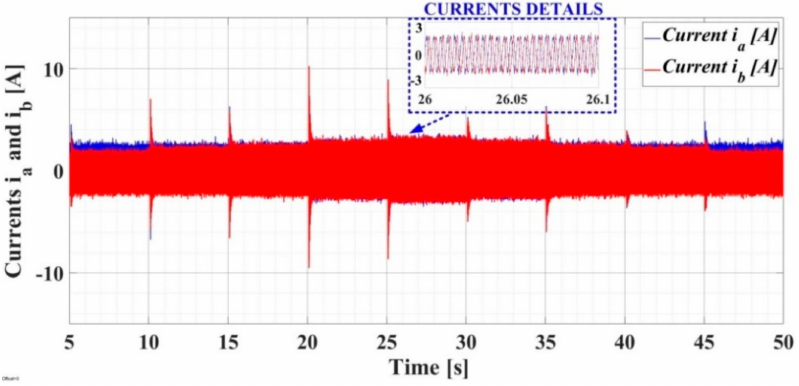
Figure 26. Real-time evolution of currents i a and i b for PMSM–CS–CI based on the LQR-type controller. It can be specified that the torque load of 1 Nm was provided by the TP 1410 drive system connected to the PMSM shaft. The TP 1410 servo-brake and drive system were programmable and could be used as a load for the PMSM in order to simulate the load torque. The main characteristics of the TP 1410 servo-brake and drive system in terms of the load of the PMSM were a speed ranging between − 4000 and 4000 rpm and a maximum braking power of 400